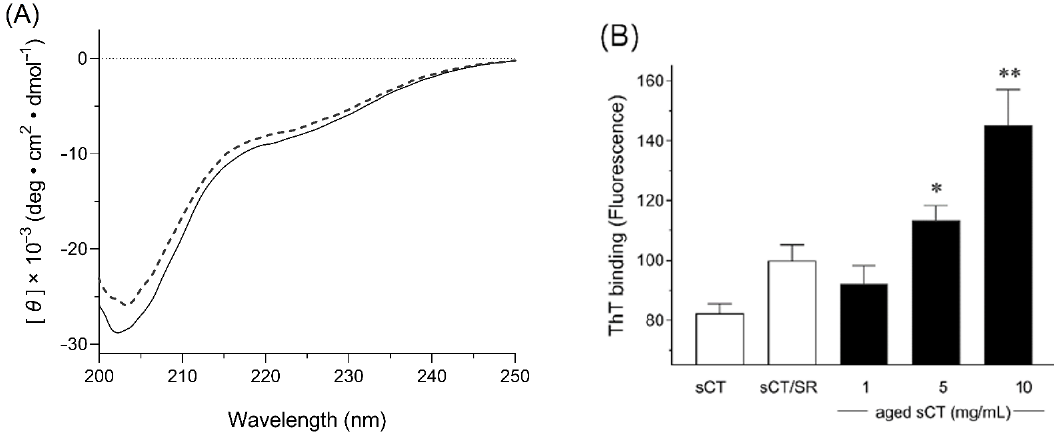
Figure 2. Changes in secondary structure of sCT during FDD process. ( A ) Circular dichroism (CD) spectrum of fresh sCT solution (solid line) and extracted sCT solution from sCT / SR (dotted line). ( B ) ThT binding assay of sCT samples. The aggregated sCT in diluted solutions were detected by the thioflavin T binding assay. Non-aged sCT, and sCT / SR were dissolved in 20 mM PBS (pH 7.4). *, p < 0.05; and **, p < 0.01 vs. non-aged sCT. Each bar represents mean ± SE of 3 independent